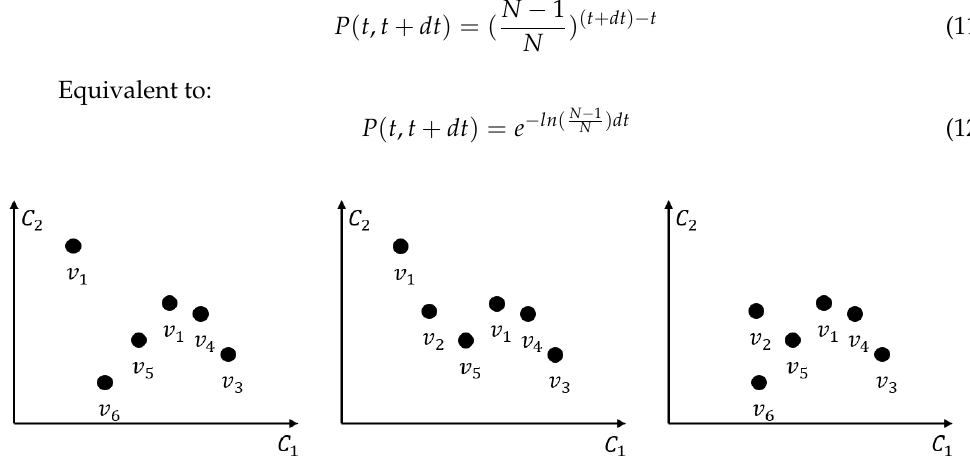
Figure 8. Three results of updating the background model sample set when N =